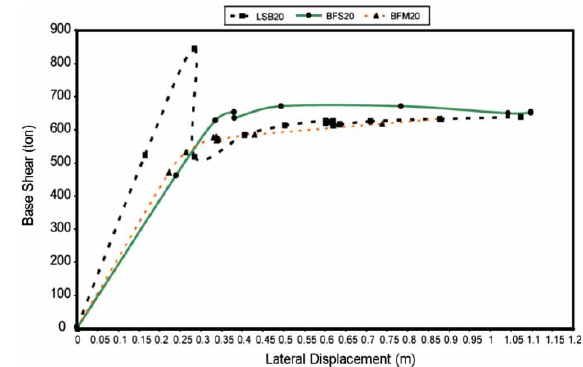
Fig. 24. Summations of uplifts in the whole models